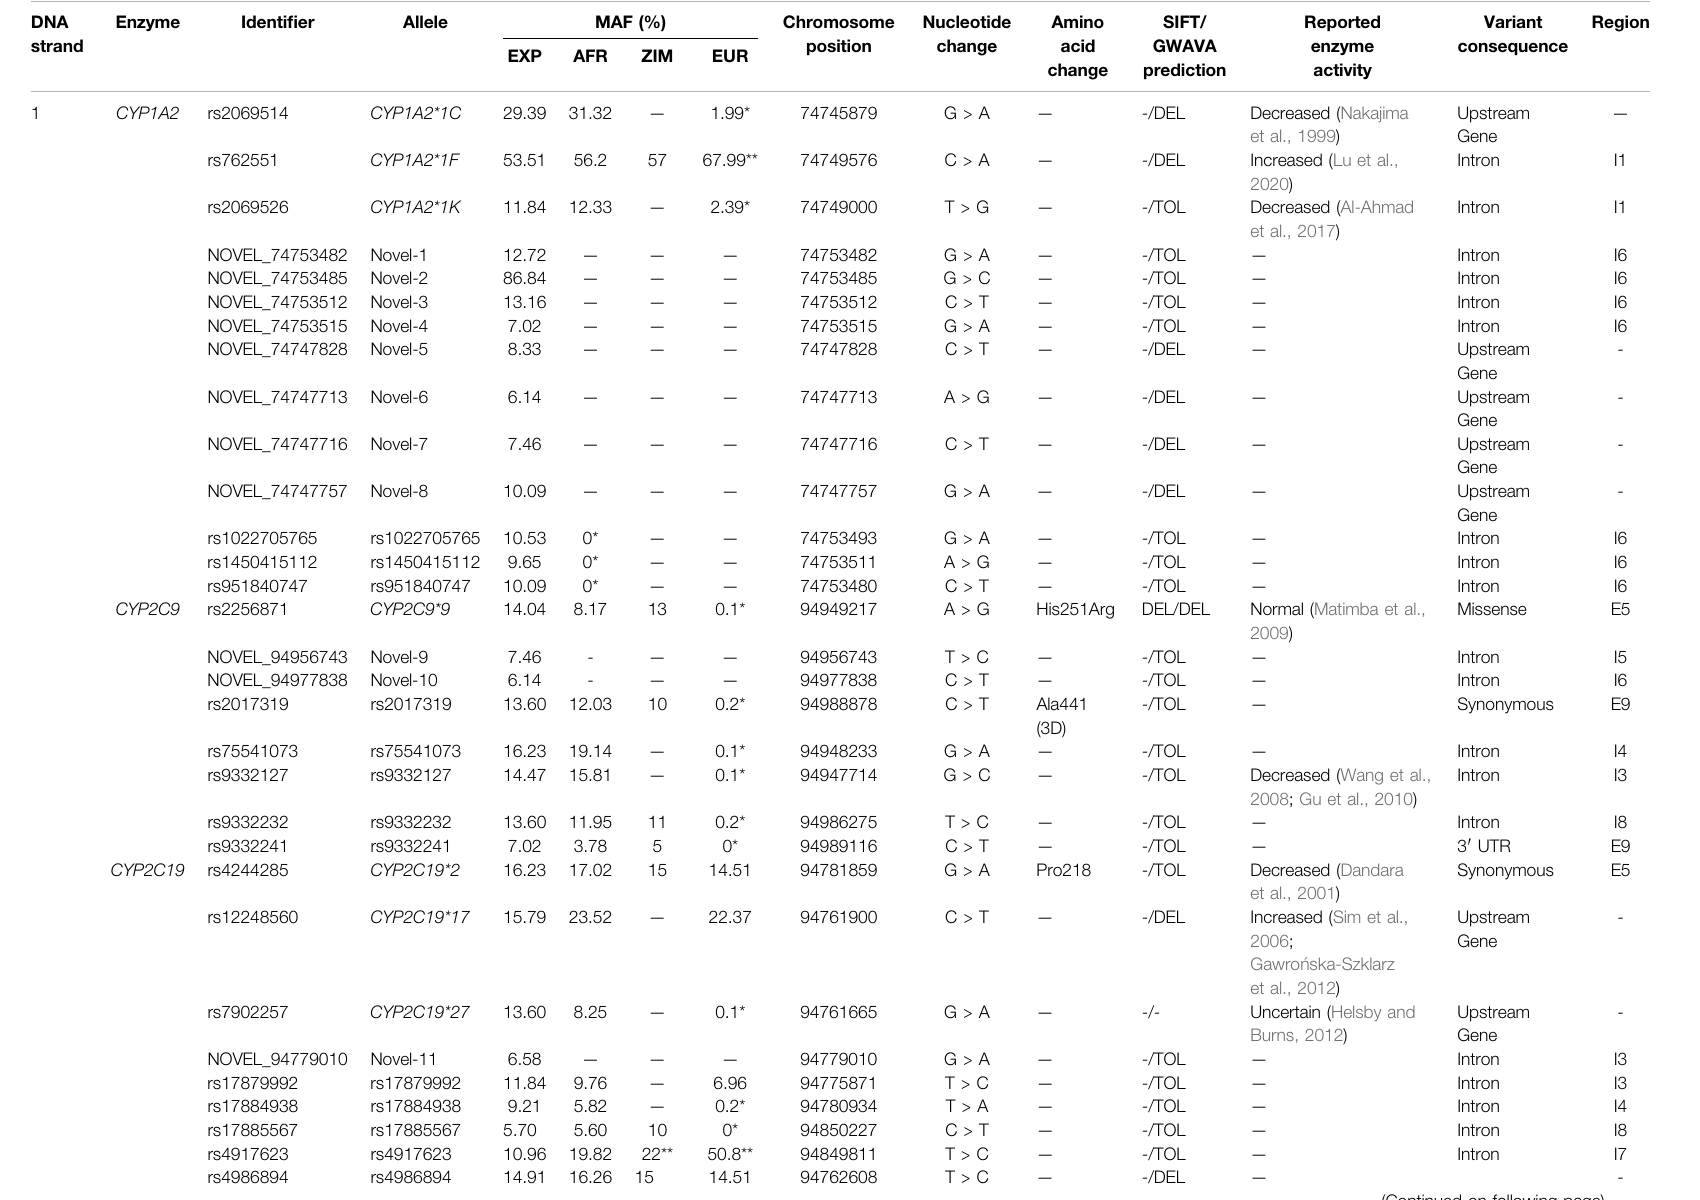
TABLE 1 | Characteristics and minor allele frequency (MAF) of the 70 single nucleotide polymorphisms (SNPs) detected in the Zimbabwean subjects. Each SNP had a MAF > 5%, and the predicted and reported functional changes of each cytochrome P450 (CYP) were described. DNA Enzyme strand